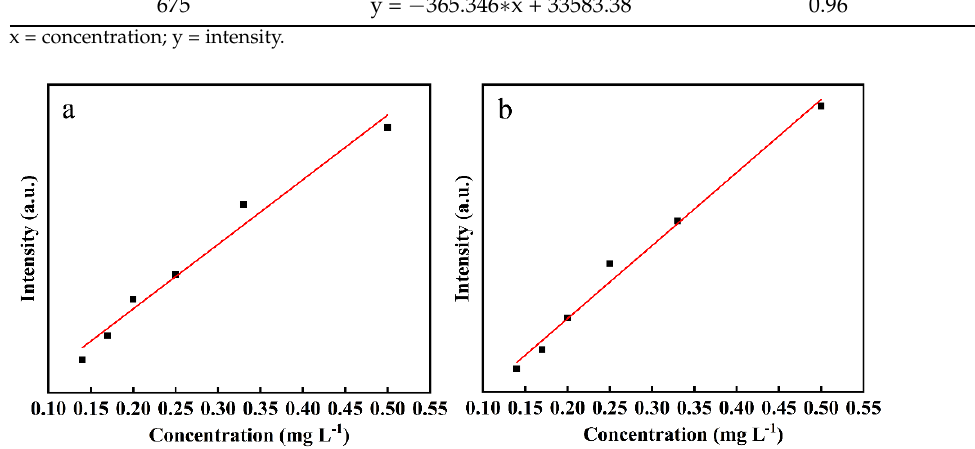
Figure 10. Linear relationship for apple surface samples treated with mixed pesticide. Relation- ships of intensities of the SERS characteristic peak at ( a ) 675 cm − 1, ( b ) 392 cm −